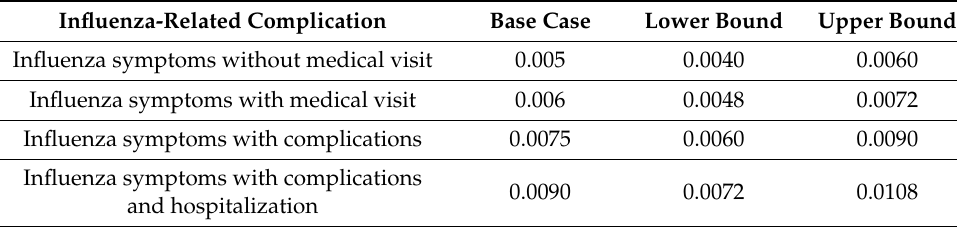
Table A9. Lower and upper bounds for influenza-related complications disutilities.